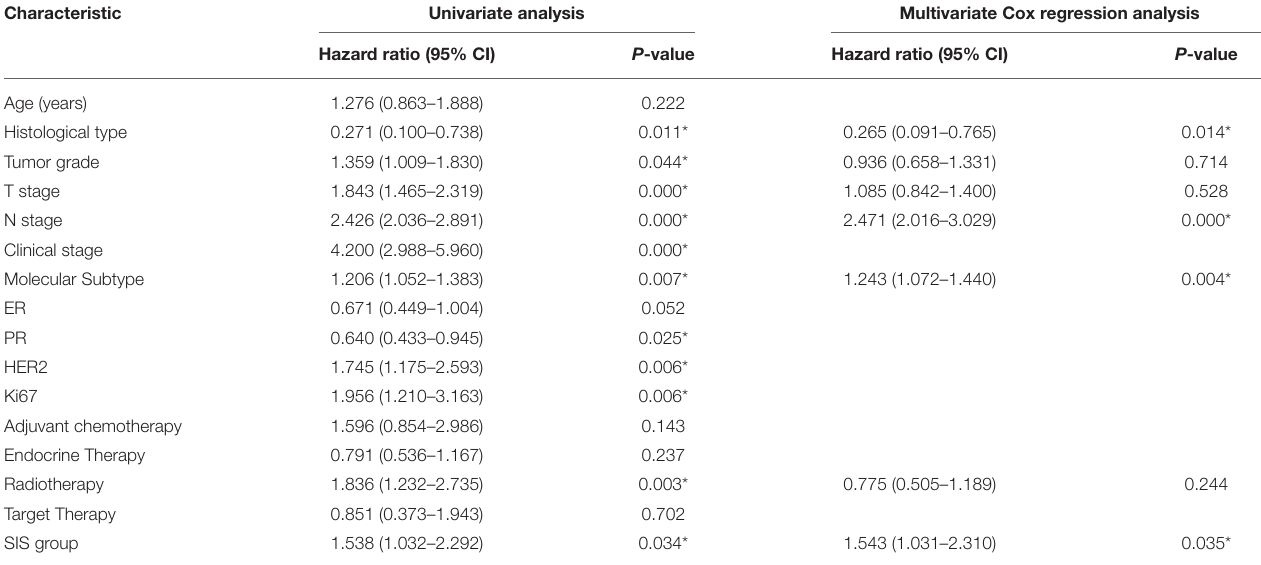
TABLE 3 | Univariate and multivariate analyses of overall survival in the training set. Characteristic